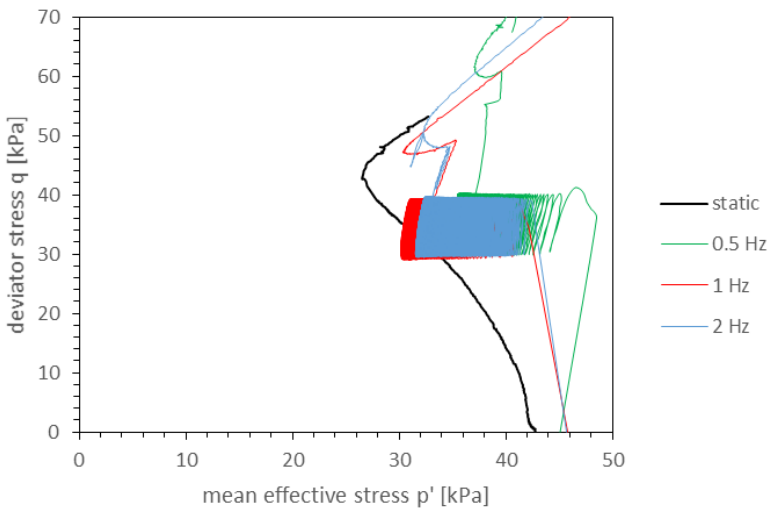
Figure 9. Deviator stress—mean effective stress plot.